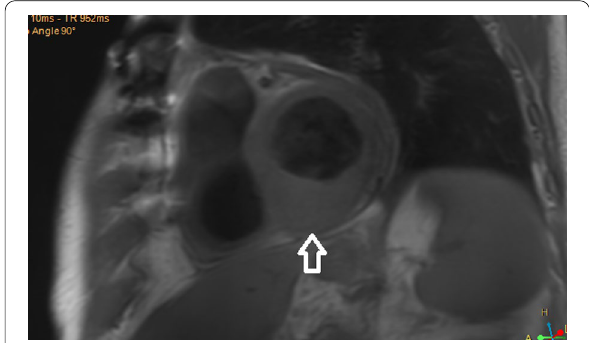
Fig. 2 Cardiac Magnetic Resonance Imaging: T1-weighted image